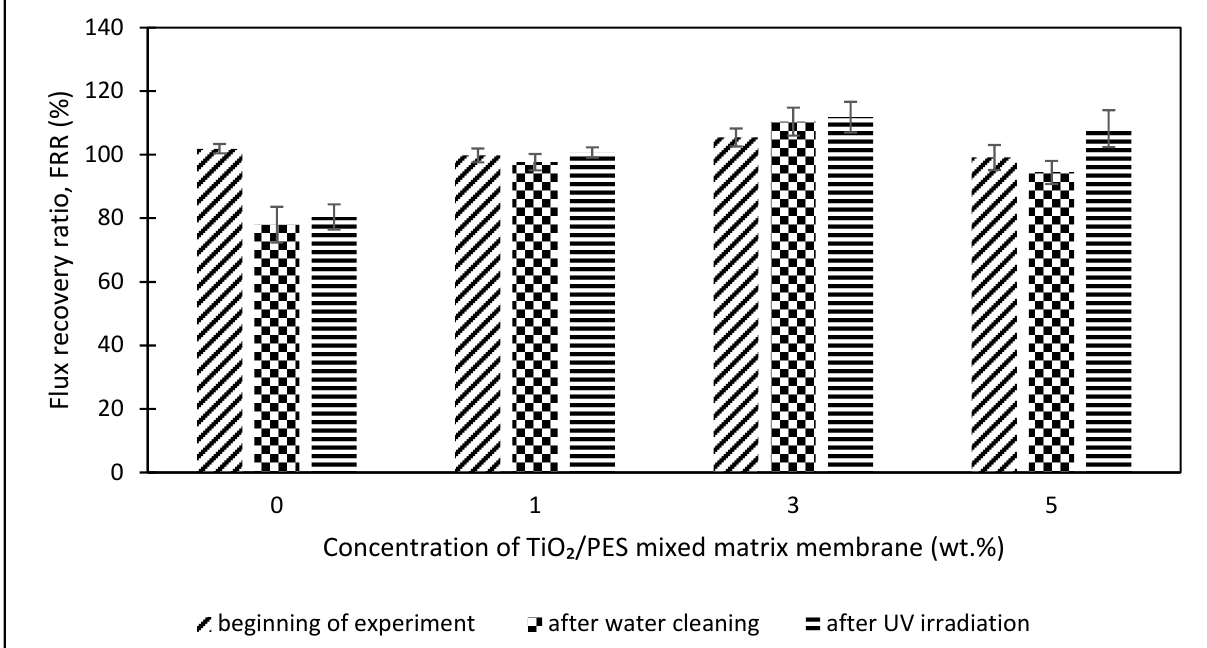
Concentration of TiO₂/PES mixed matrix membrane (wt.%) beginning of experiment after water cleaning after UV irradiation Figure 8. Comparison of FRR among different concentrations of TiO 2 /PES mixed matrix membrane at the beginning of the experiment, after water cleaning, and after UV irradiation